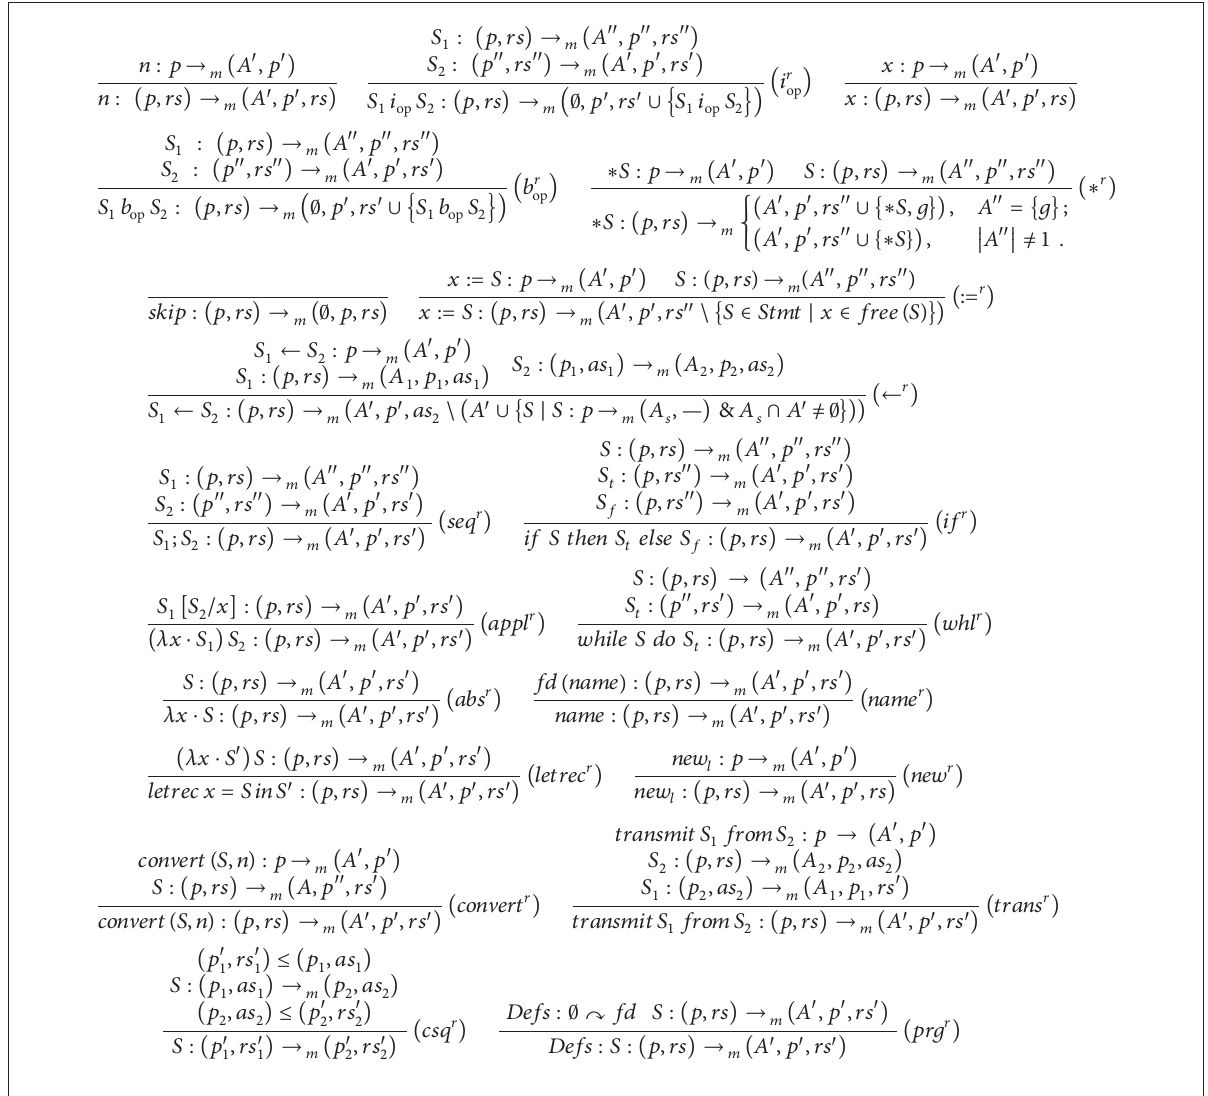
Algorithm 1: Inference rules of the ready type